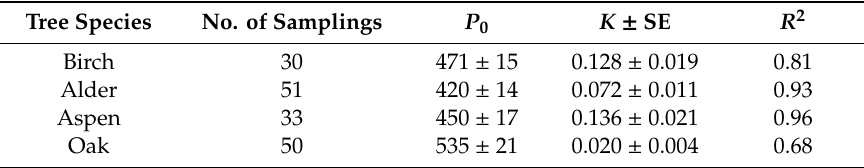
Table A3. Decomposition rates of CWD and their parameters (d > 10